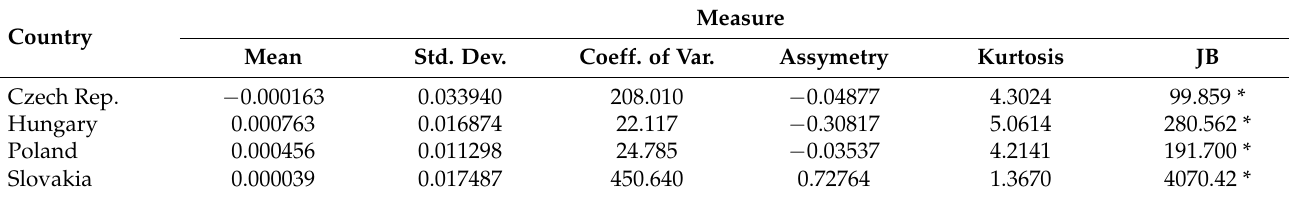
Table 2. Summary statistics for diesel weekly